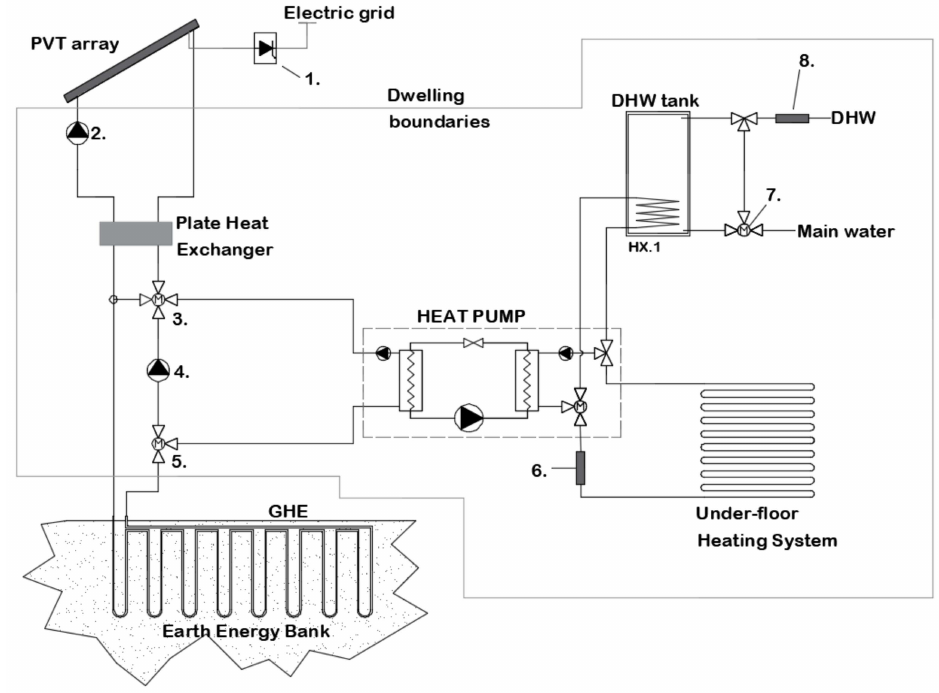
Figure 3. SAGSHP system’s layout: 1. DC to AC inverters; 2. Solar system pump; 3. Four-way deviator; 4. Solar-soil charging pump; 5. Three-way deviator; 6. Space heating auxiliary heater; 7. Temperature control valve; 8. DHW auxiliary